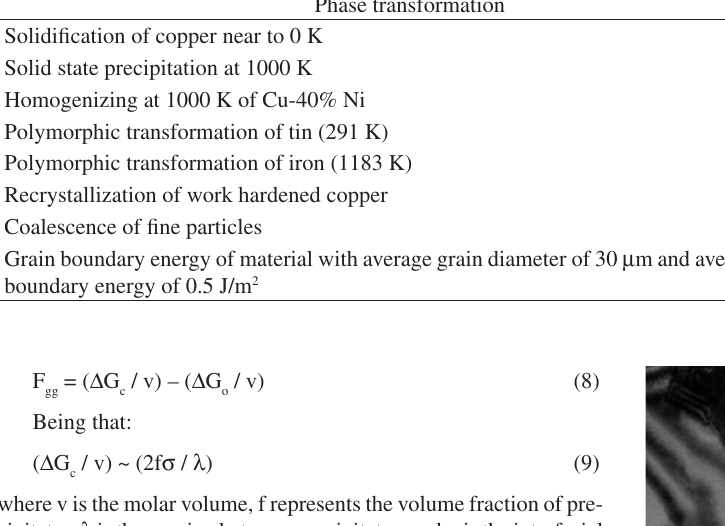
Table 3. Driving forces for some phase transformations and solid state reactions 94 . Phase